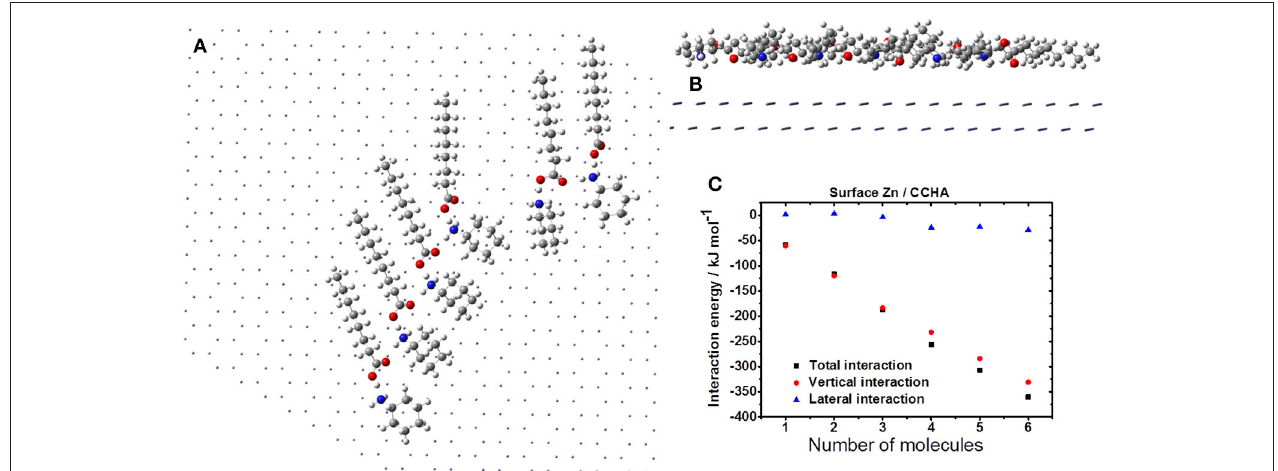
FIGURE 6 | Formation of CCHA film on the zinc surface: horizontal (A) and vertical (B) views; (C) interaction energy.